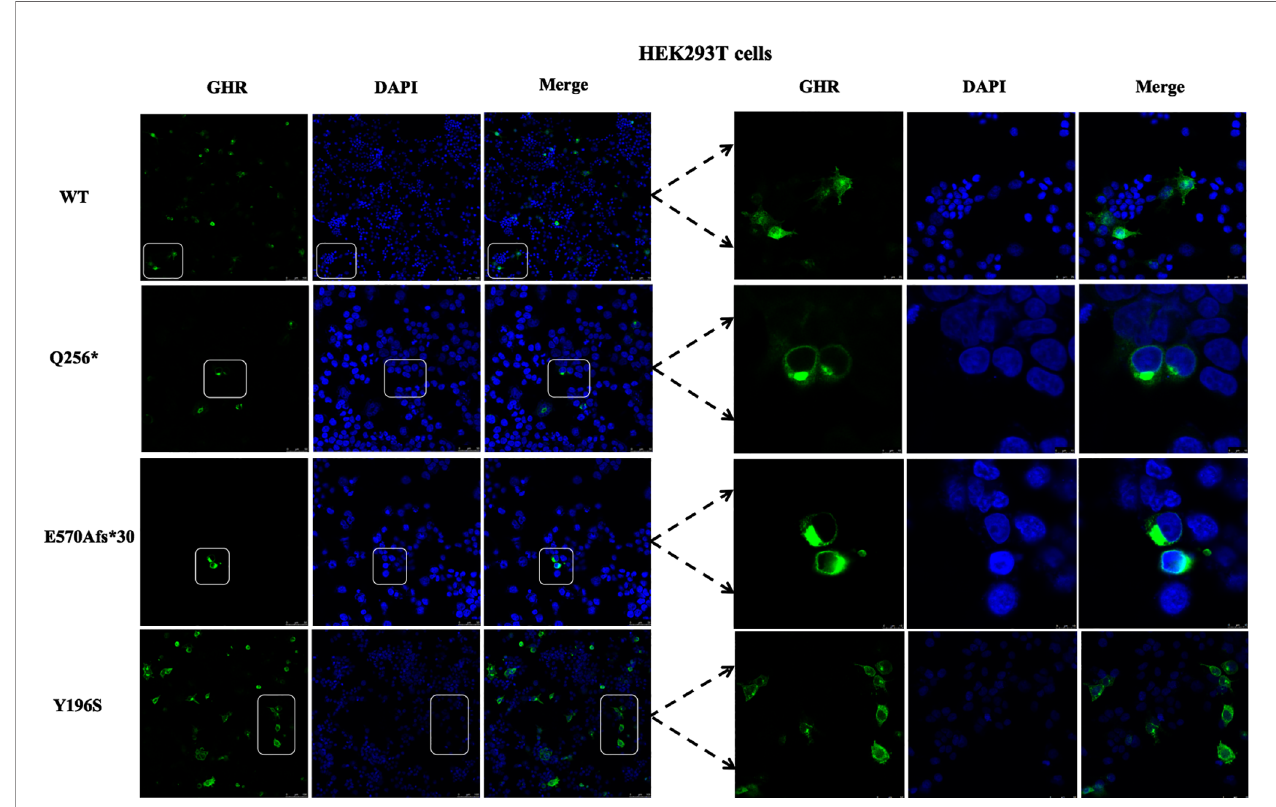
FIGURE 3 | Immuno fl uorescence images of HEK293T cells transfected with GHR wild type (WT) and mutant expression plasmids (Q256*, E570Afs*30 and Y196S). The GHR protein was labeled by anti-HA primary antibody in green, the nucleus was labeled by DAPI in blue, and the merged images were displayed in the right